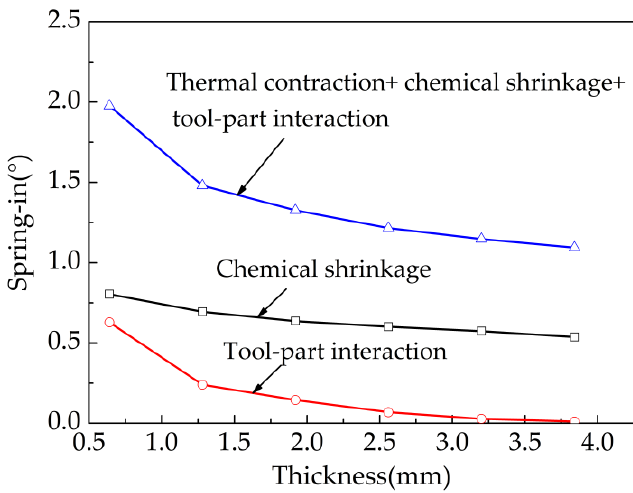
Figure 11. Influence of part thickness on spring for L-shaped parts.